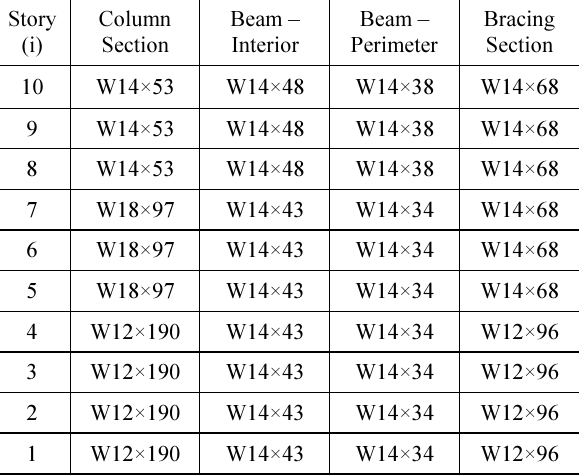
Table 3. Member designs for Eccentrically Braced Frame